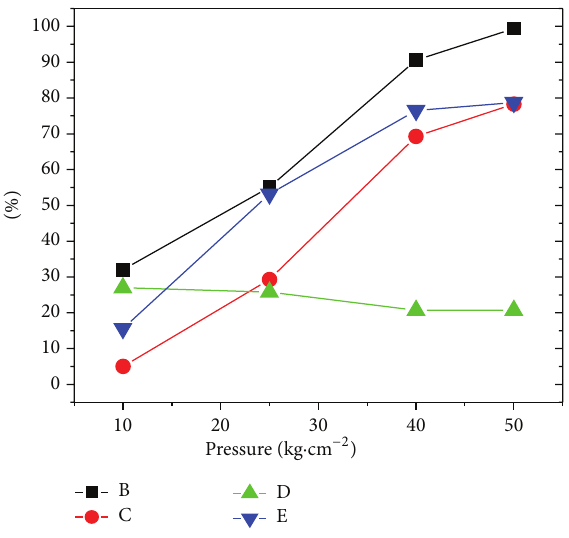
Figure 5: Effect of duration of reaction. B = conversion, C = 2-PEA yield, D = others, and E = 2-PEA selectivity.